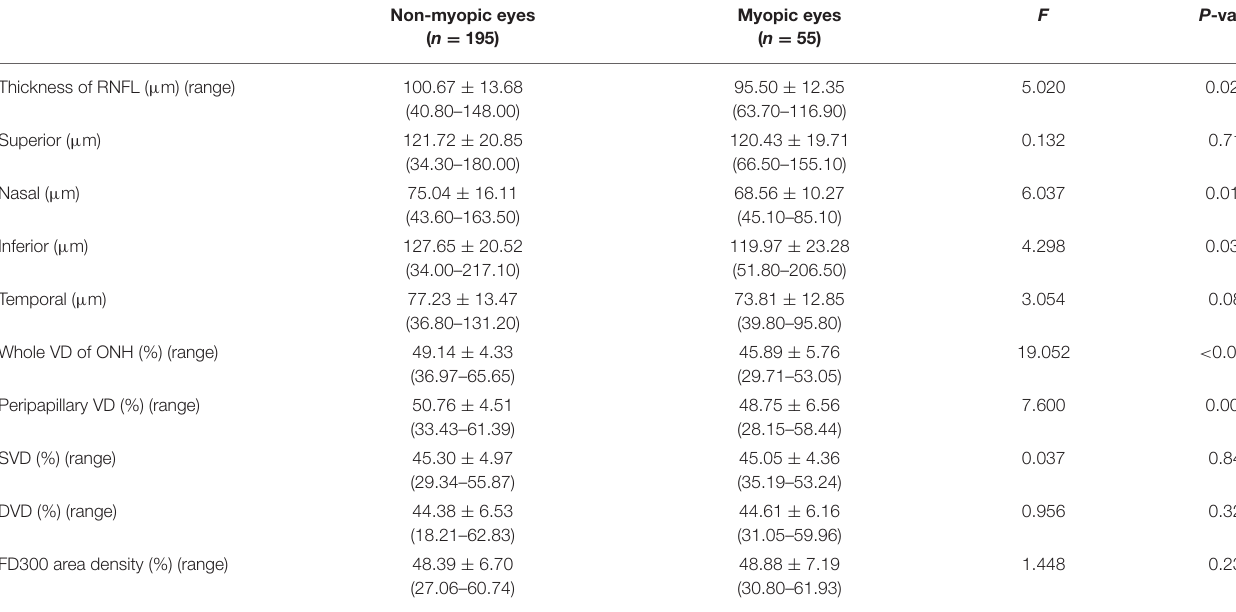
TABLE 2 | Differences of RNFL and VD between non-myopic and myopic eyes of diabetes.